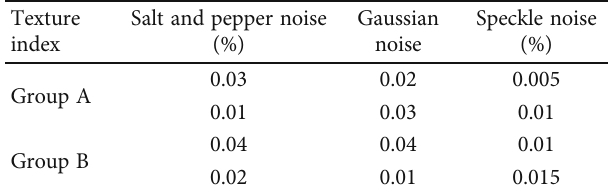
Table 1: Oil painting texture characteristic attribute